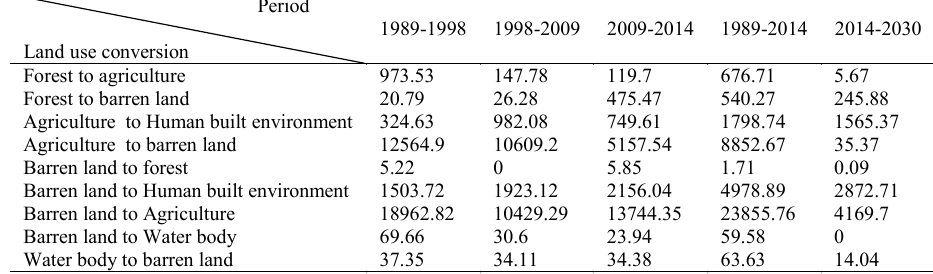
Table 6: Land use class change and conversion during the time span (ha) Period